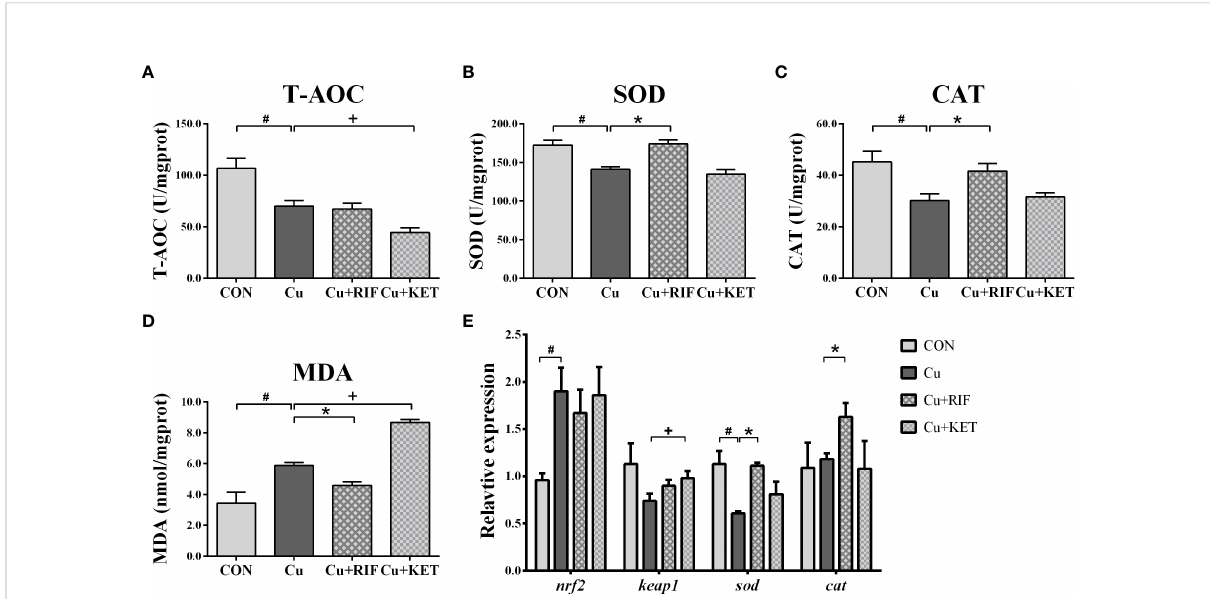
FIGURE 4 Enzyme activities and transcriptional levels of antioxidant systems in the liver of largemouth bass subjected to RIF or KET under Cu exposure (n = 6). (A) T-AOC: total antioxidant capacity; (B) SOD: superoxide dismutase; (C) CAT: catalase; (D) MDA: malondialdehyde; (E) hepatic mRNA levels of nrf2 , keap1 , sod , cat1 . Signi fi cant differences between CON and Cu groups, Cu and Cu+RIF groups, as well as Cu and Cu+KET groups were indicated by “ # ” , “ * ” , and “ + ” ( P <